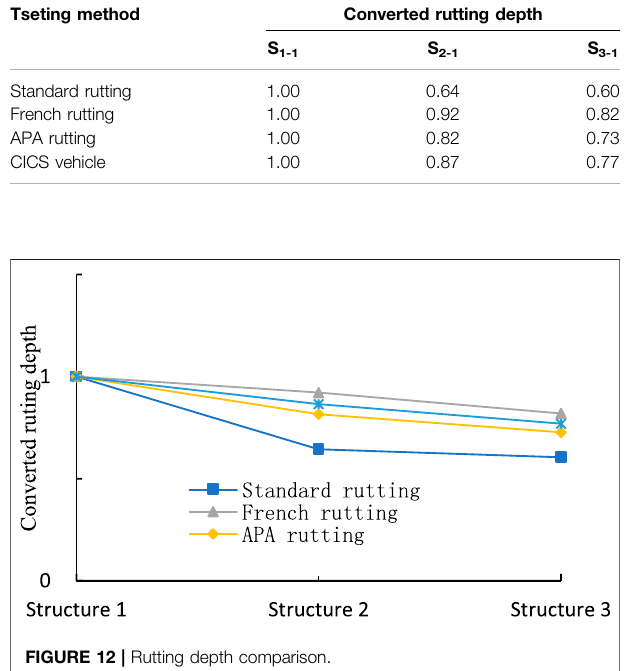
FIGURE 12 | Rutting depth comparison.